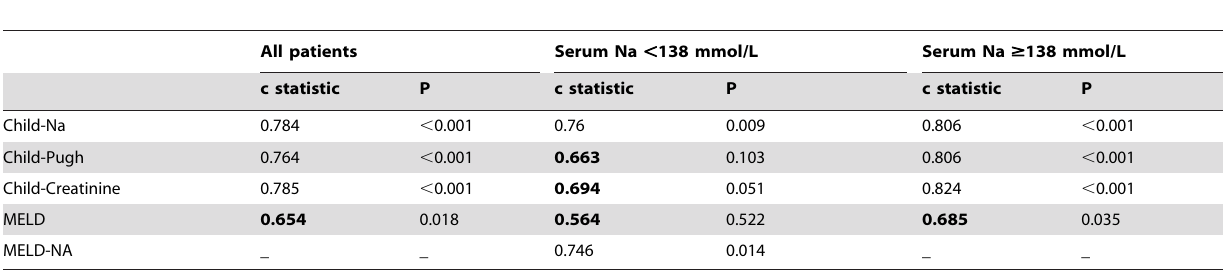
Table 4. ROC curve analysis of the Child-Na score, Child-Pugh score, Child-Creatinine score, MELD score, and MELD-NA score, according to the level of serum Na.